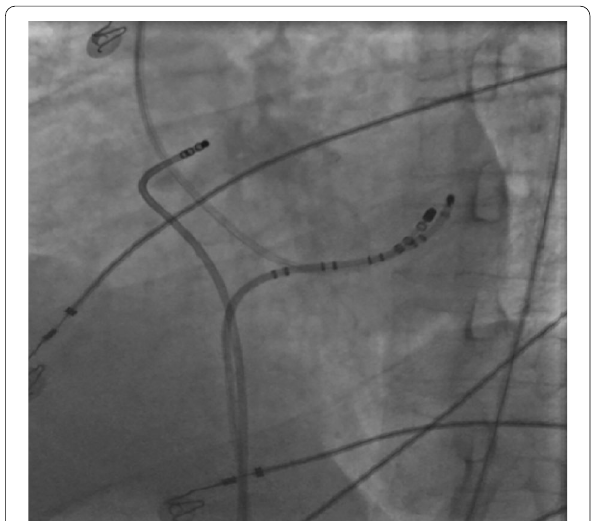
Fig. 1 Left lateral view of catheter positions during ablation